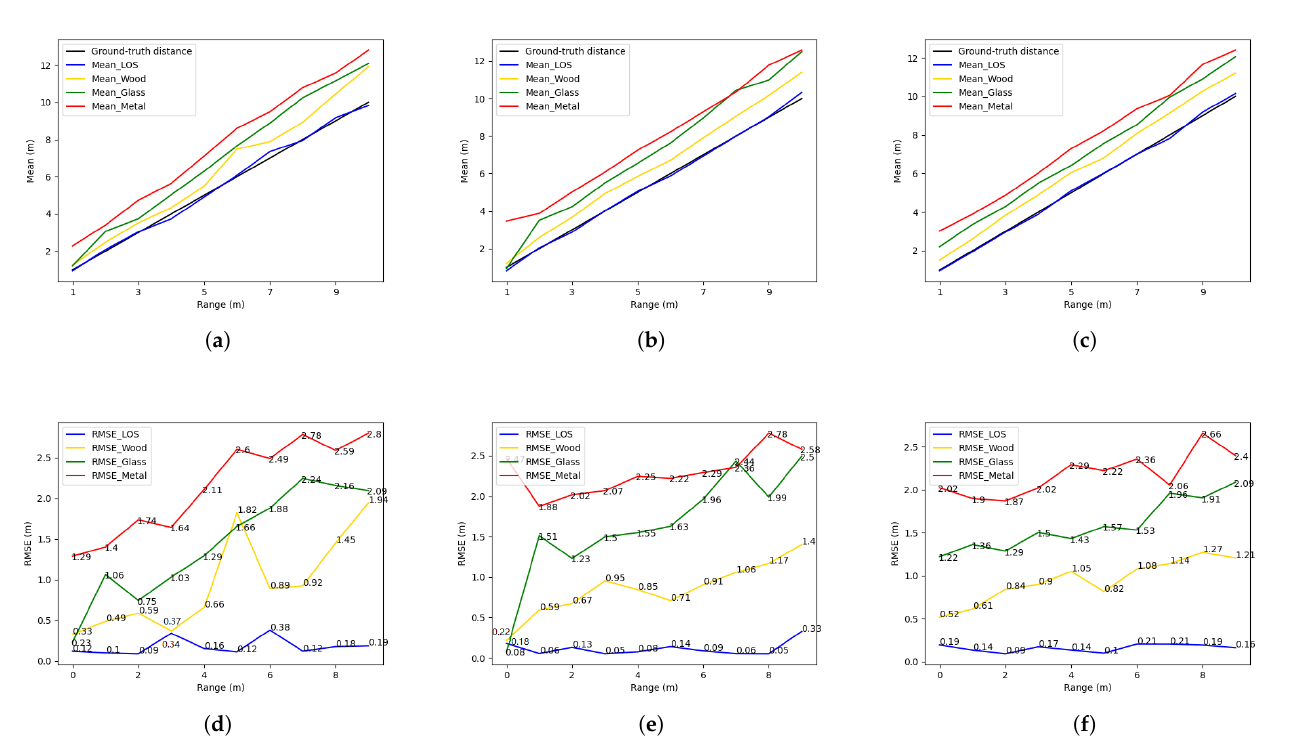
Figure 9. Wi-Fi RTT distance and error in RFPF and NLOS condition: ( a ) Wi-Fi RTT distance from Google Pixel 2; ( b ) Wi-Fi RTT distance from Xiaomi Redmi K20; ( c ) Wi-Fi RTT distance from LG V50S; ( d ) RMSE of Wi-Fi RTT distance from Google Pixel 2; ( e ) RMSE of Wi-Fi RTT distance from Xiaomi Redmi K20; ( f ) RMSE of Wi-Fi RTT distance from LG